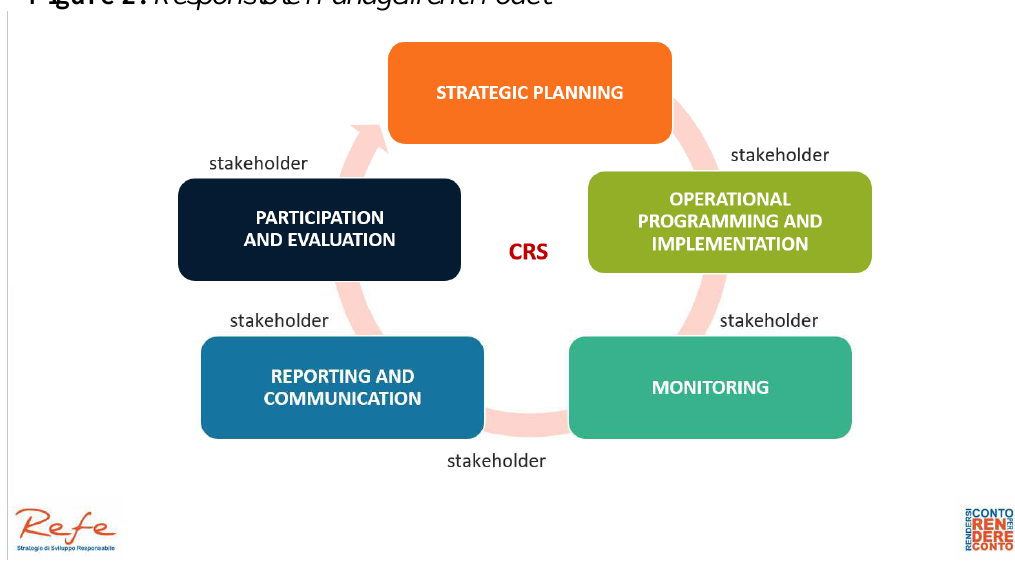
Figure 2: Responsible Management Model